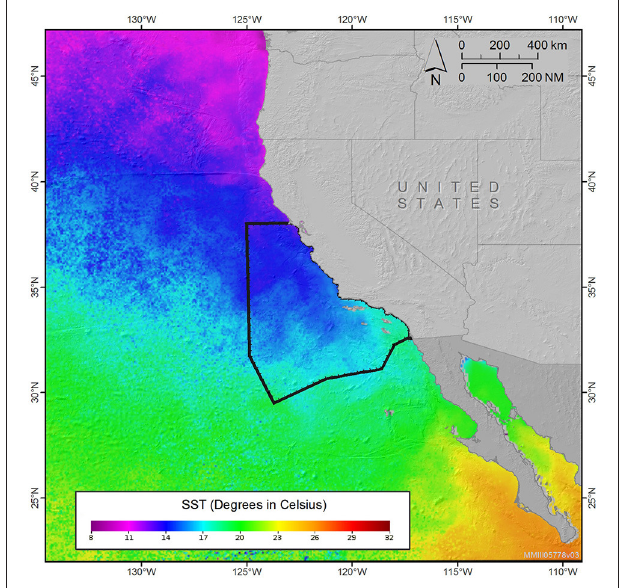
FIGURE 7 | Monthly sea surface temperature composite for a representative cool season period (December 2015) for the U.S. west coast, showing the cool water extending southeast from Point Conception (34.4 ◦ N). This cool-water region corresponded to the lowest densities of short-beaked common dolphin shown in Figure 4A , and the general southern extension of Dall’s porpoise shown in Figure 4B , coincident with water temperatures of roughly 16 ◦ C. The study area boundary is shown with a solid black line. SST data provided courtesy of NOAA CoastWatch: